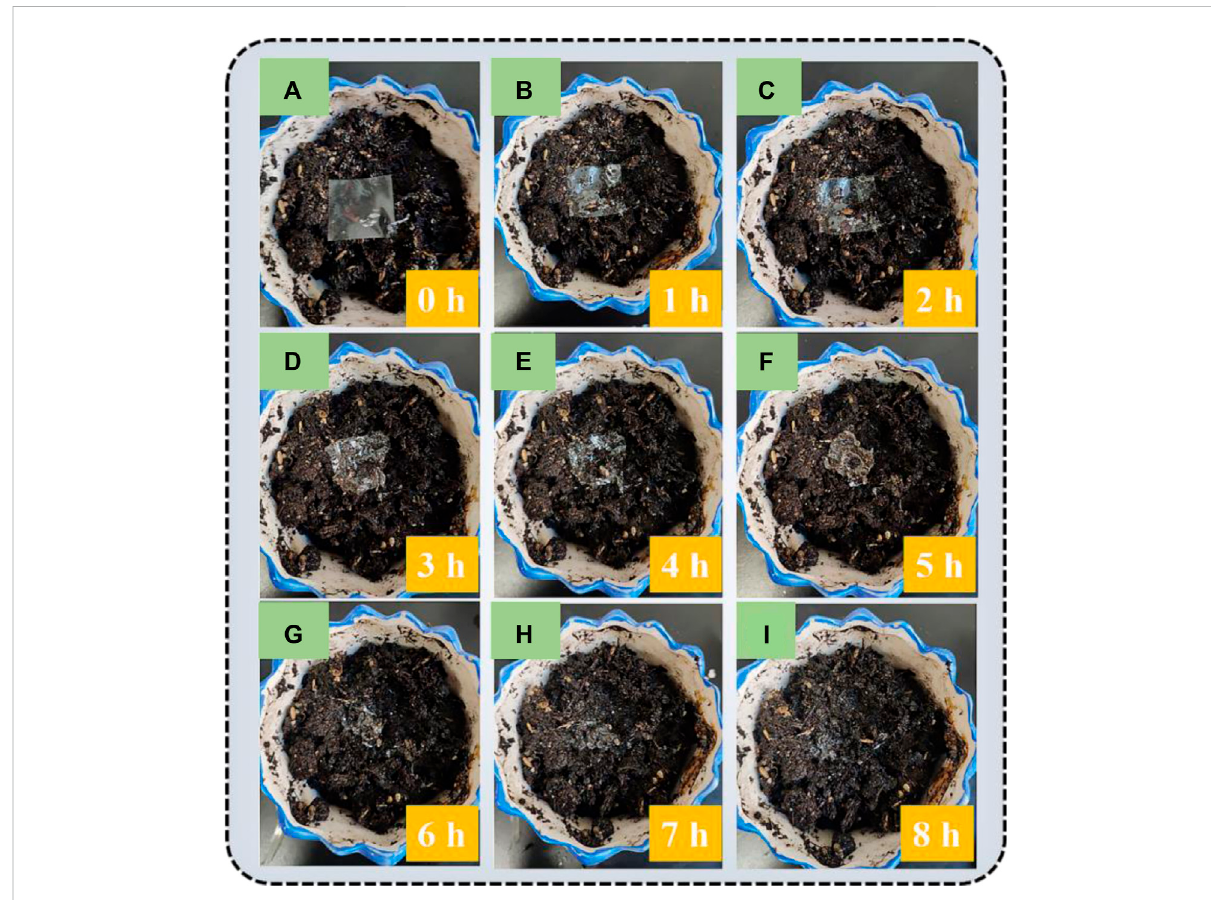
FIGURE 7 The degradable test of AgNWs/Ti 3 C 2 T x -FG/PVA fi lm. (A-I) are corresponding to the picture of the fi lm after 0-8h of